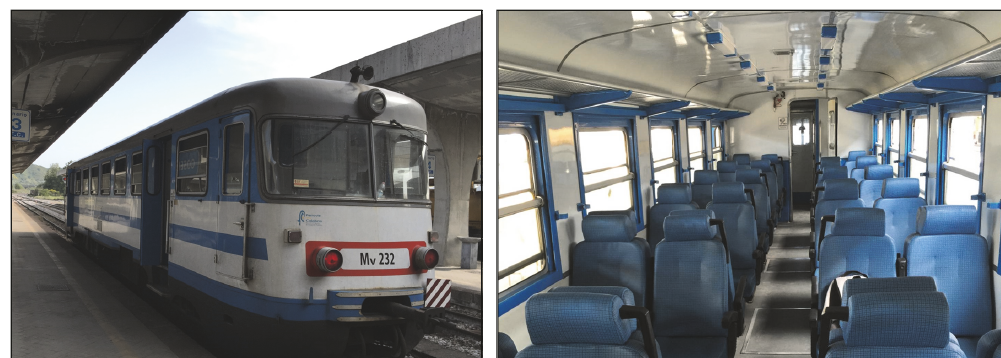
Figure 10: FCL M2.200 BREDA Railcar.